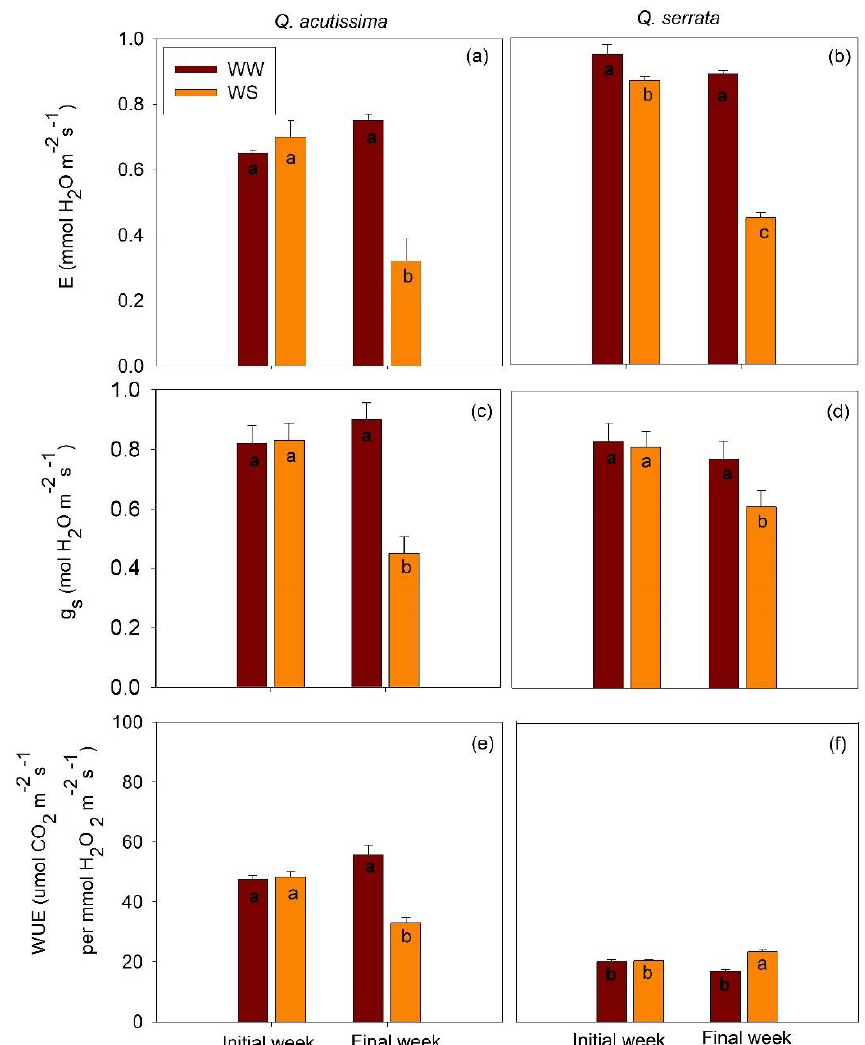
Figure 7. ( a , b ) Transpiration (E), ( c , d ) stomatal conductance (g s ), and ( e , f ) water use efficiency (WUE) of Quercus acutissima and Q. serrata in well-watered (WW) and water-deficit stress (WS) treatments. Vertical bars indicate the SE (n = 10). Comparison means derived using Tukey’s test ( p < 0.05) are shown for the significant interaction between water stress and time. Different lowercase letters indicate significant differences. Gas exchange measurements were performed in still-green leaves.